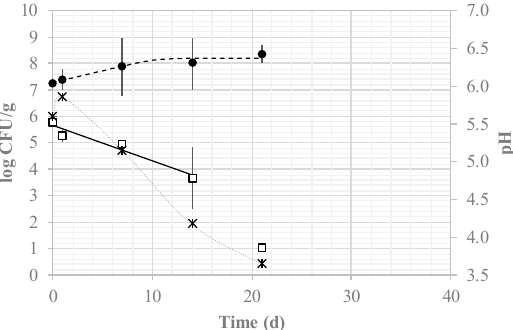
Figure 4. Total bacterial counts, S. aureus survival and pH evolution during Domiati cheese ripening for 35d storage after the addition of a yoghourt starter culture. • Observed growth of total bacterial counts (dashed line corresponds to the fi tt ed Baranyi model); □ Observed survival of S. aureus (solid line corresponds to the fi tt ed Weibull model); × pH evolution. After examining the antibacterial e ff ect of di ff erent concentrations of the studied nanoparticles, 35 µg/mL was the minimum inhibitory concentration (MIC) that could